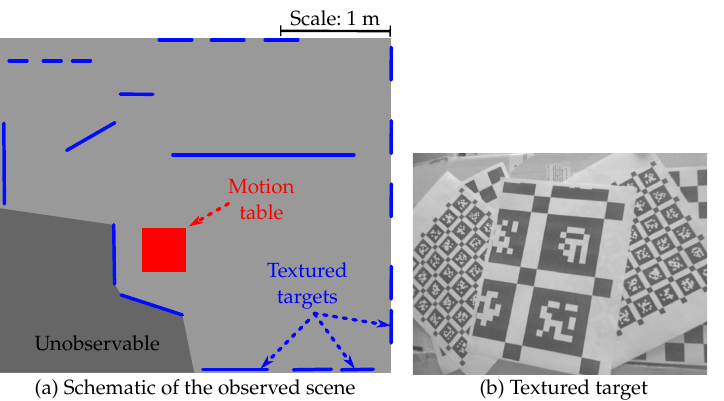
Figure 5. Picture of the custom experimental setup consisting of a stereo camera setup mounted on a three-axis (xy–yaw) motion table.